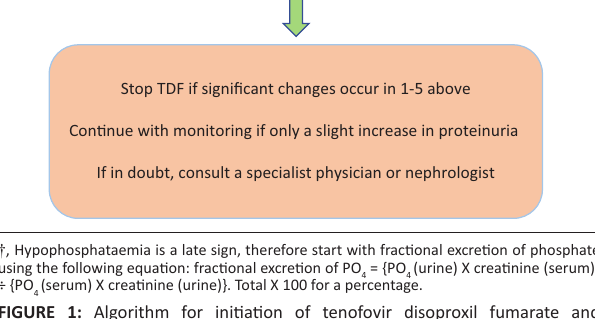
FIGURE 1: Algorithm for initiation of tenofovir disoproxil fumarate and monitoring of tenofovir disoproxil fumarate-associated nephrotoxicity. Should multiple risk factors for TDF toxicity be present in a patient, closer monitoring may be